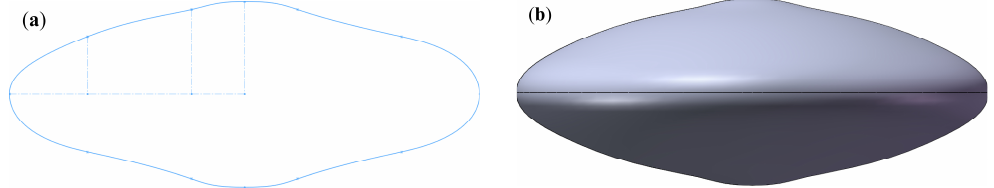
Figure 12. Optimization results: ( a ) AUH profile with optimized decision variables; ( b ) 3D AUH shell with optimal design parameters.